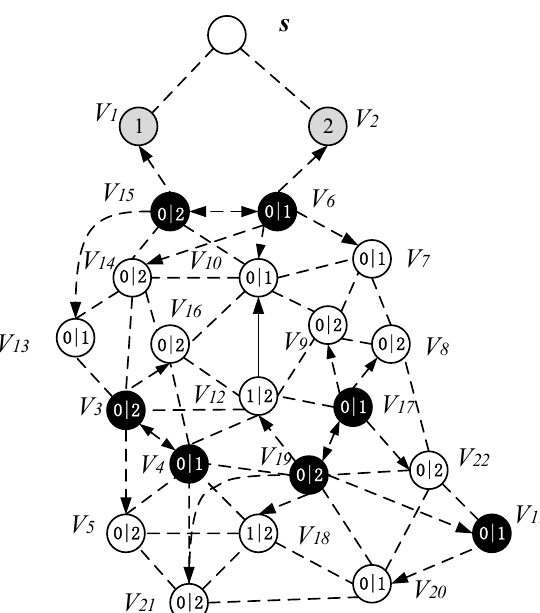
Figure 24. Topology diagram after adjusting node time slot.